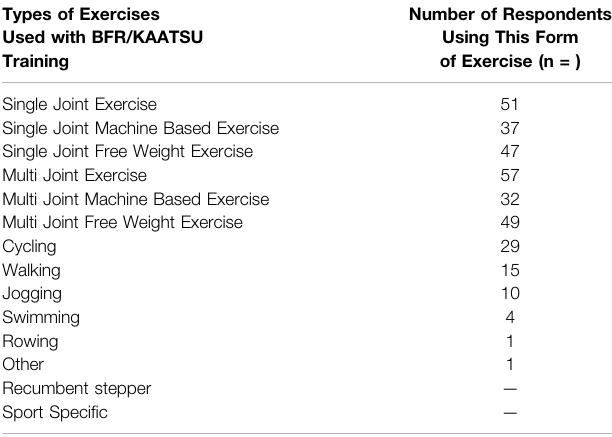
TABLE 3 | Exercise employed with BFR/KAATSU